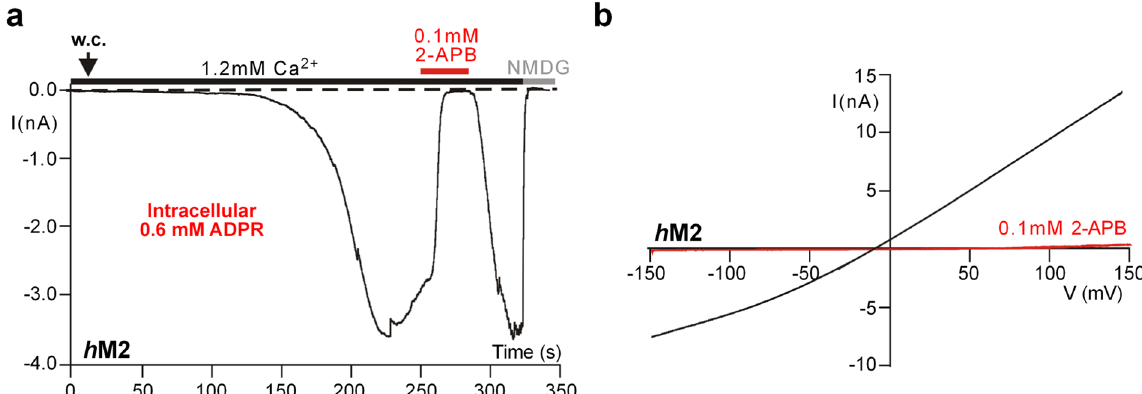
Figure 2. Reversible current inhibition by 2-APB in human TRPM2. ( a ) The slowly activating and hardly inactivating currents through this channel were promptly, completely, and reversibly inhibited by 2-APB (0.1 mM) applied to the standard bath. ( b ) Corresponding current-voltage relations to the experiment shown in panel a. The voltage ramps show that the inward as well as the outward current component is equally